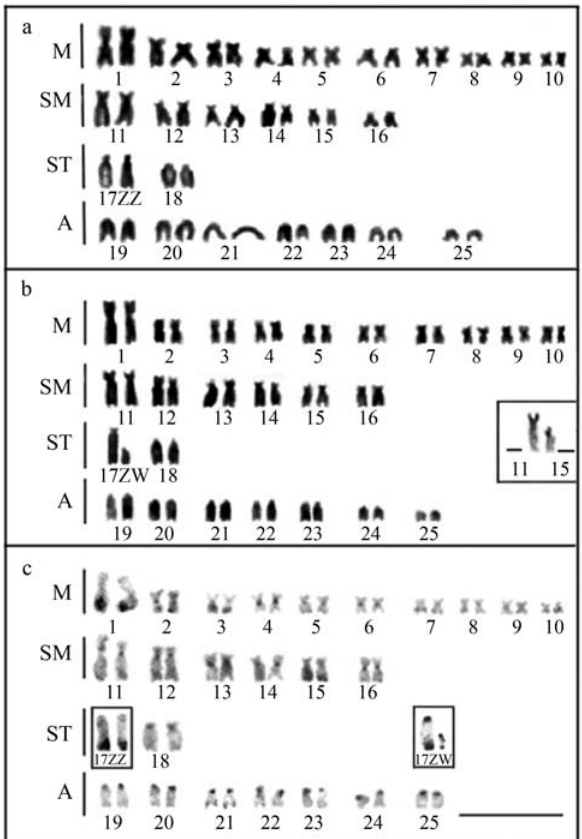
Figure 1 - Giemsa-stained (a) and C-banded (b) karyotypes of Carnegiella marthae . The Ag-NOR-bearing chromosomes are shown in the insert (c). Bar - 10 μ